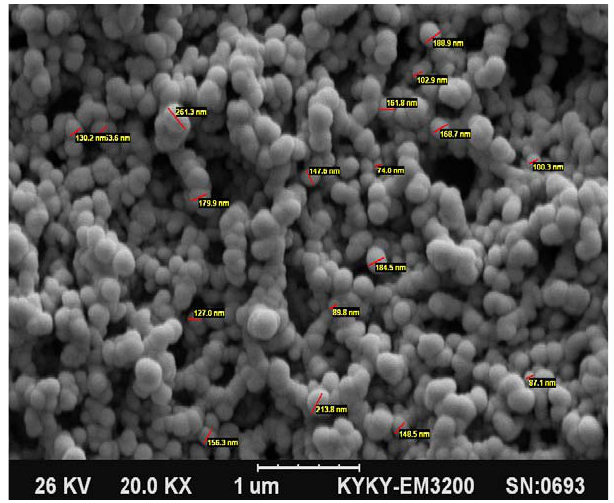
Fig. 1. SEM micrographs of sample S7